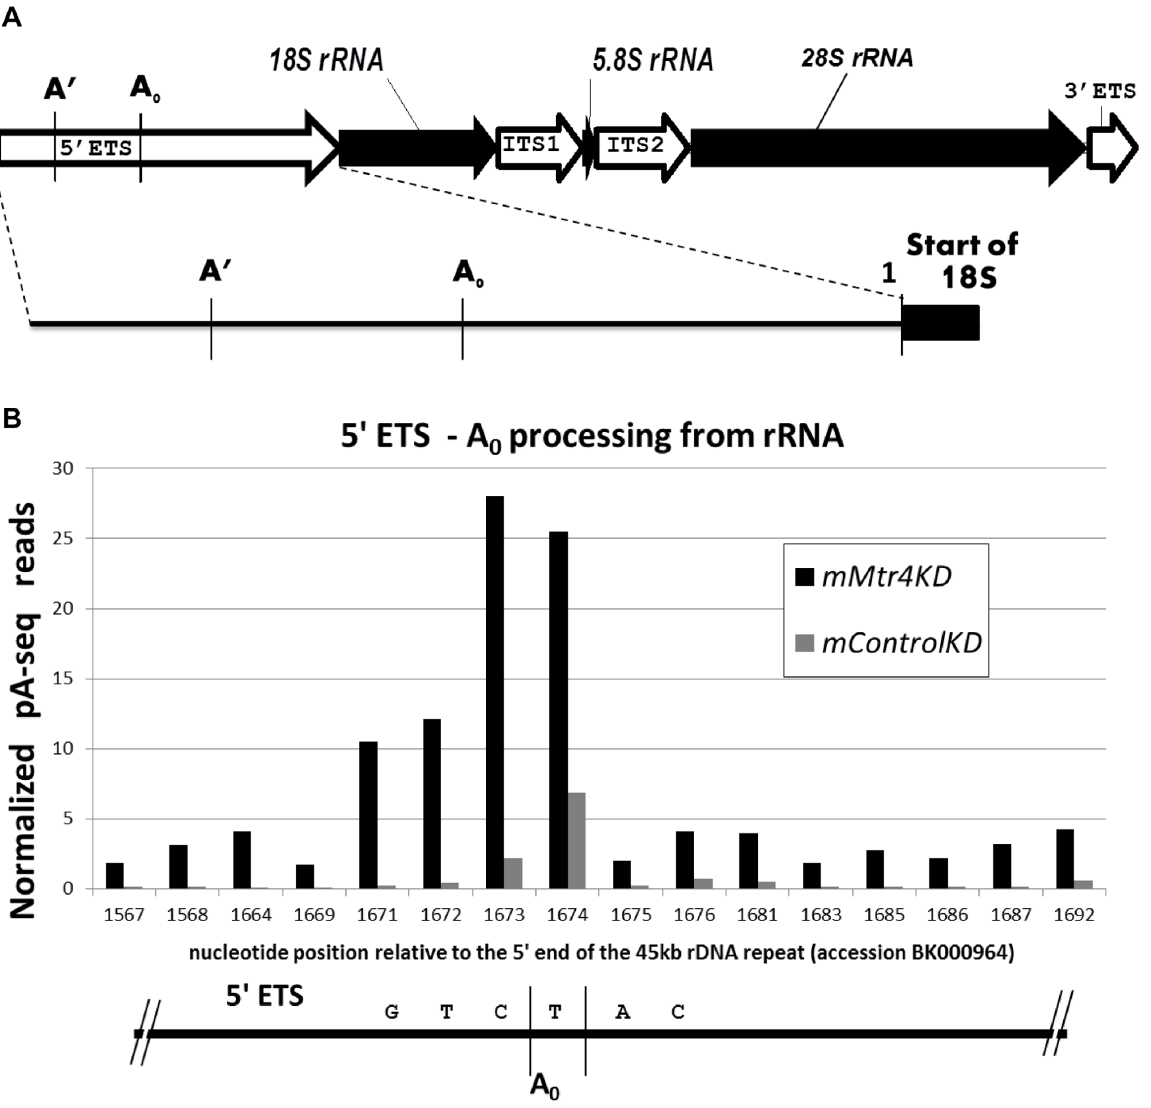
Figure 3. Adenylated 5 9 ETS transcripts accumulate in mMtr4 KD. 3A ) Schematic of precursor rRNA and relevant processing sites. The above schematic depicts the External and Internal Transcribed Spacers (ETS and ITS, respectively) of mouse pre-rRNAs. The 18S, 5.8S, and 28S rRNAs are shown as filled black arrows, whereas the External and Internal Transcribed Spacers (ETS and ITS, respectively) are shown as unfilled arrows. The 5 9 ETS is enlarged below to show the approximate locations of processing sites A 9 , A 0 , and the 18S junction (site # 1). Processing site